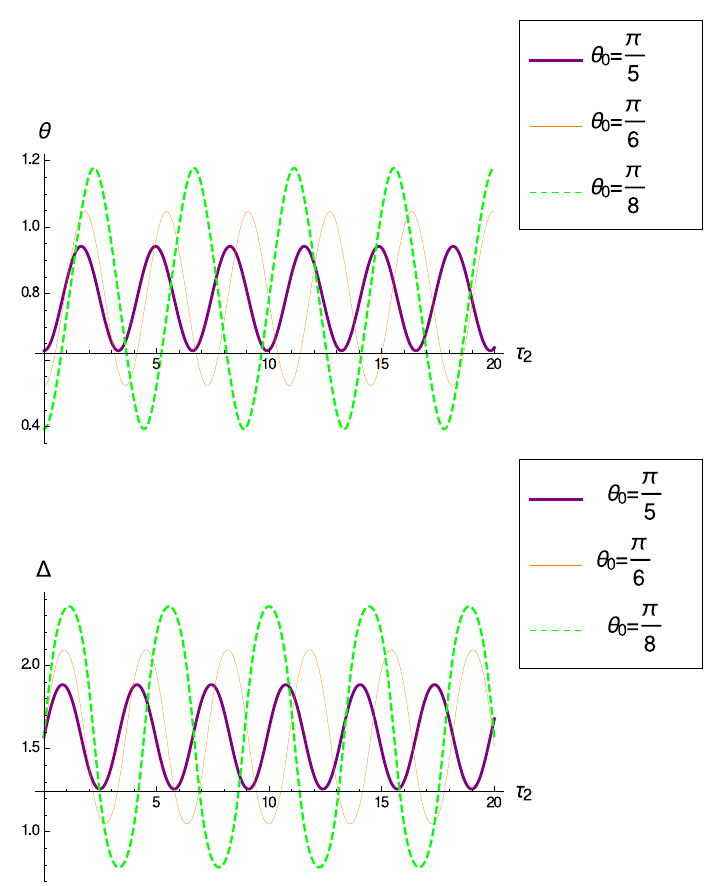
Figure 2. Top panel: Graph for θ for different initial values of θ 0 . Bottom panel: Graph for ∆ for different initial values of θ 0